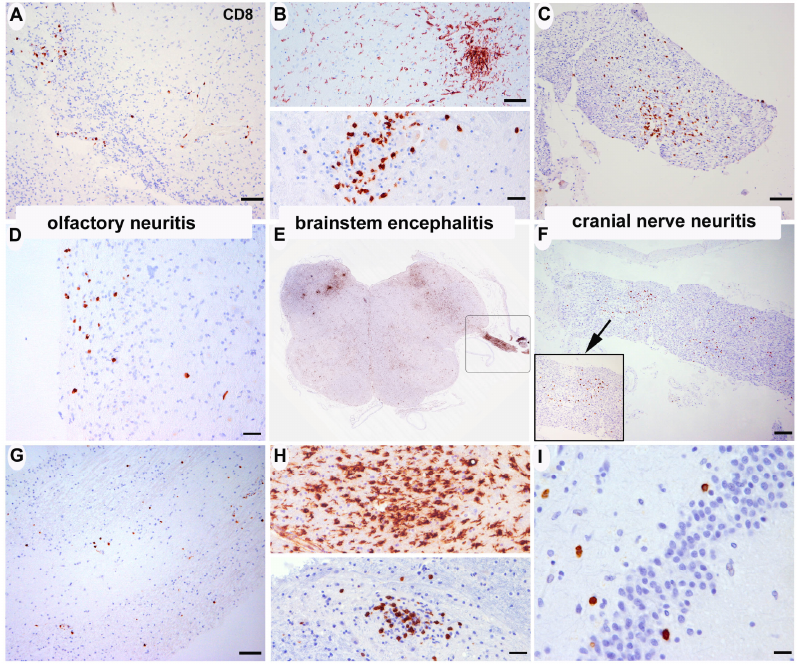
Figure 1. Inflammatory changes. ( A , D , G ) Focal cellular infiltrates of CD8+ T-lymphocytes in the olfactory bulb/tract ( A ), case 2; ( D ), case 5; ( G ), case 22) (anti-CD8 immunohistochemistry). ( B , E , H ) Focal nodular accumulation of CD8+ T-lymphocytes and HLA-DR+ microglia in the medulla oblongata ( B ), upper panel anti-HLA-DR, lower panel anti-CD8, case 3; ( E ), anti-HLA-DR, case 5; ( H ), upper panel anti-HLA-DR, lower panel anti-CD8, case 4). ( C , F ) Focal cellular infiltrates of CD8+ T-lymphocytes along emerging cranial nerves (vagus) ( C ), case 2; ( F ), case 5). ( I ) Isolated CD8+ T-cells adjacent to the dentate gyrus of the hippocampus (case 4). Scale bars: ( A , B ) (upper panel), ( C , G ) 50 μm; ( B ) lower panel, ( D , H ) 20 μm; ( E ) ×0.7; ( F ) 100 μm; ( I ) 10 μm.